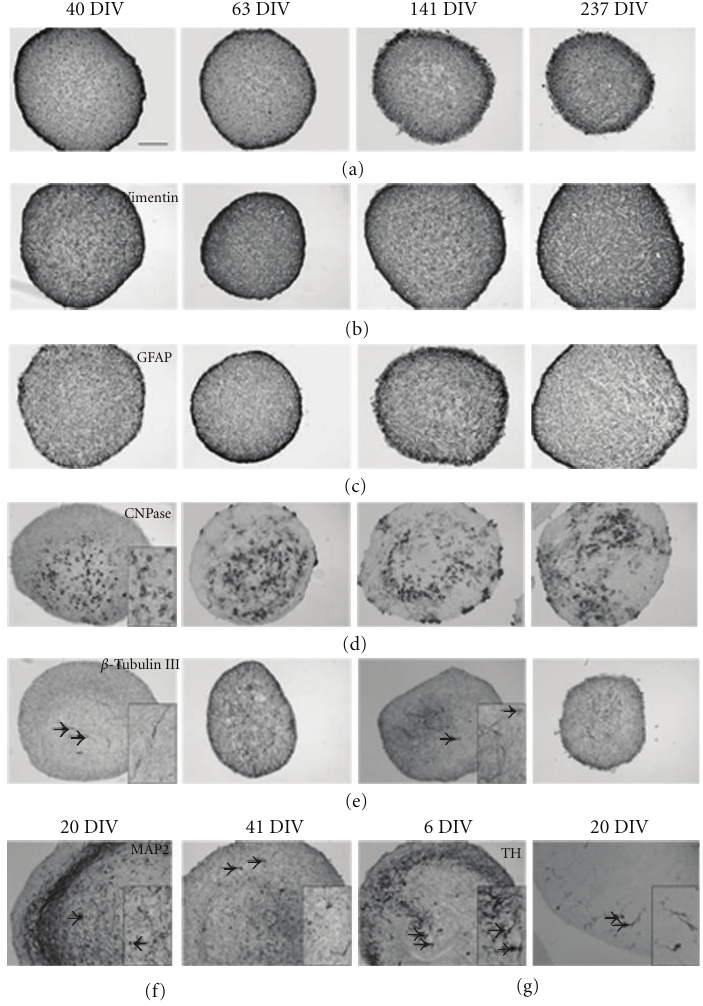
Figure 5: Neural stem cell, glial, and neuronal markers in long-term propagated embryonic porcine ventral mesencephalic, neural tissue- spheres (NTS), stained after 40, 63, 141, and 237 days in vitro (DIV). Photomicrographs showing immunoexpression of nestin (a), vimentin (b), GFAP (c), CNPase (d), and β Tubulin III (e) in NTS. The neuronal marker MAP2 and the dopaminergic marker TH were not expressed in the long-term propagated NTS, but younger NTS cultures showed MAP2 expression (f) in NTS after 20 and 41 DIV and TH expression (g) after 6 and 21 DIV. Arrows mark neuronal cell soma magnified in inserts. DIV = days in vitro . Scale bars = 100 μ m (overview) and 20 μ m